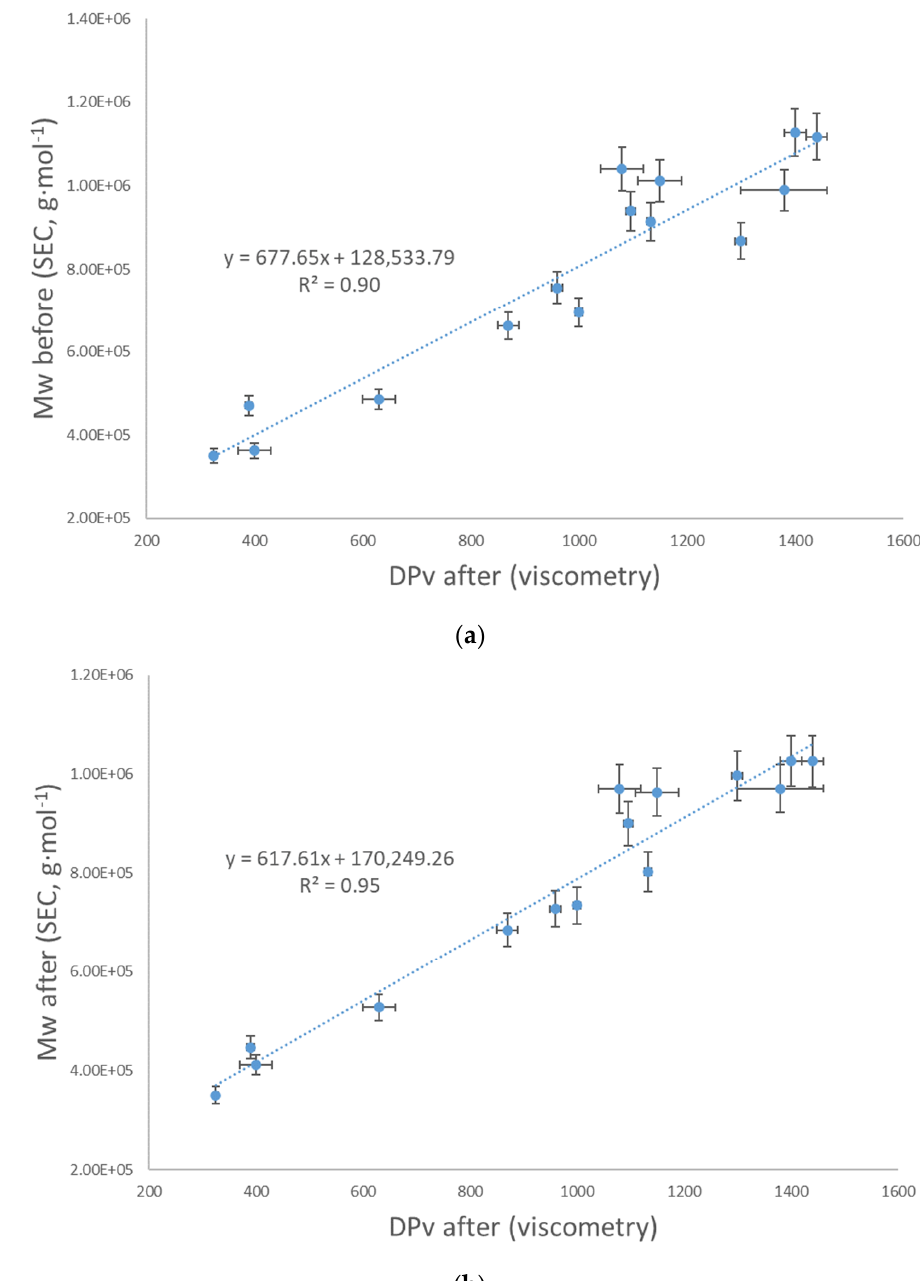
Figure 2. Mass average molecular mass of CTC derivatives of cellulose determined by SEC before ( a ) and after ( b ) delignification vs. average DP v of cellulose determined using viscometry after delignification of paper samples described in Table 1. Error bars represent standard deviations of duplicate determinations.